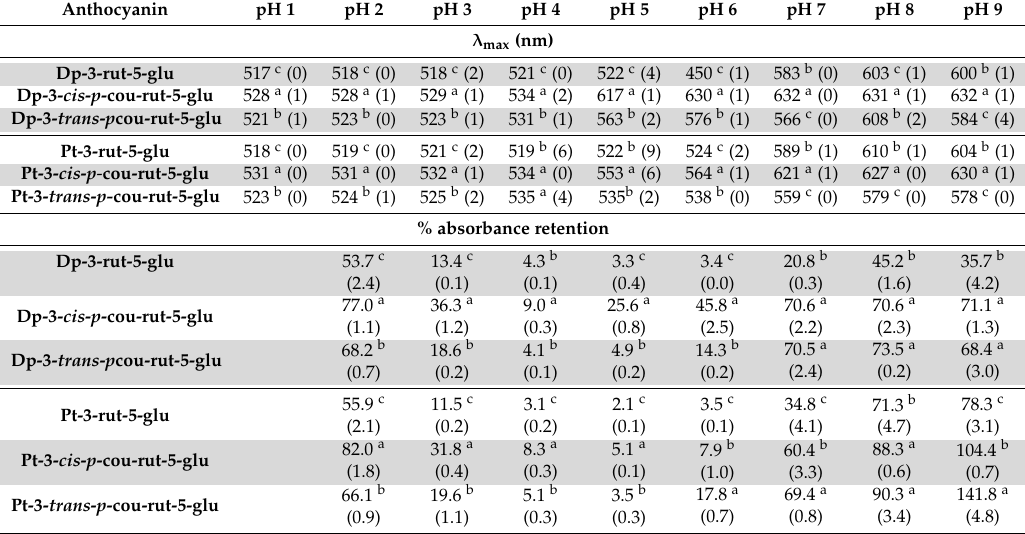
Table 1. λ max (nm) and % absorbance retention, defined as absorbance at respective λ max in pH n /absorbance in pH 1 × 100, of delphinidin (Dp) and petunidin (Pt) derivatives in pH 1–9, n = 3 (standard deviation in parenthesis). Different superscript letters indicate significant differences ( p < 0.05) between derivatives of the same anthocyanidin in the same